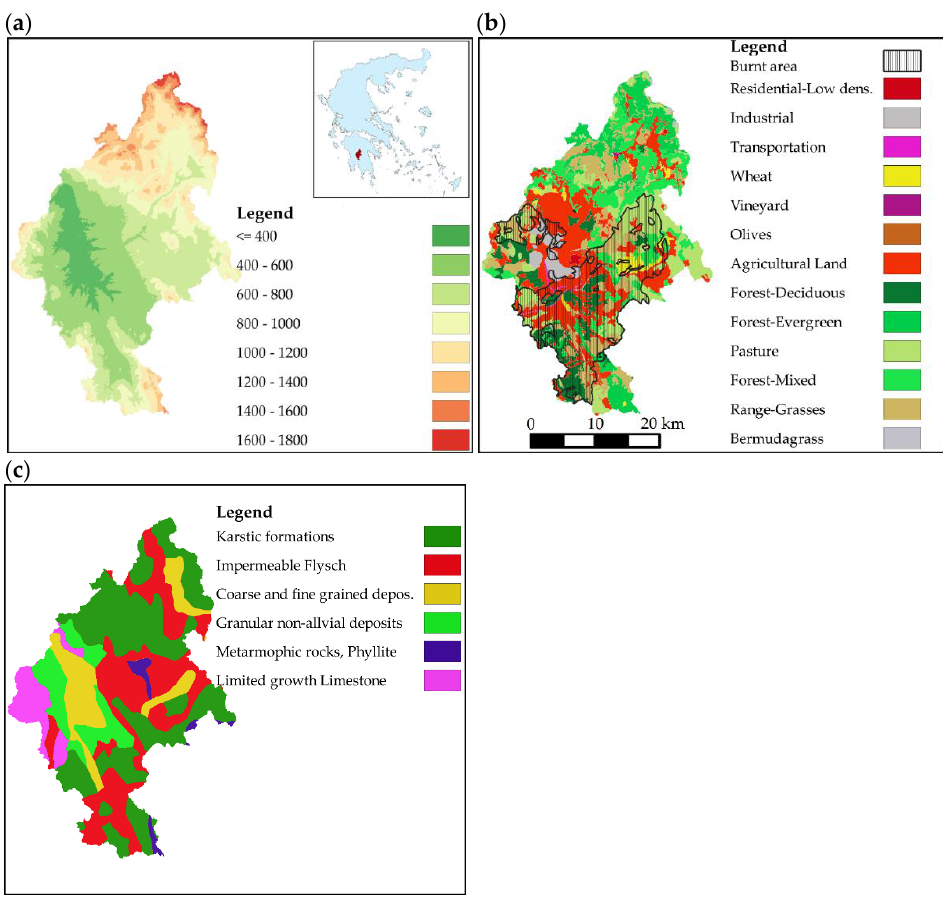
Figure 1. Physical characteristics of the study domain: ( a ) Ground elevation of the Alpheios river basin at Karytaina Bridge (Greek Geodetic Reference System ‘87); ( b ) land uses following the SWAT classification showing also the burnt areas from the forest fire in 2007; ( c ) soil types.